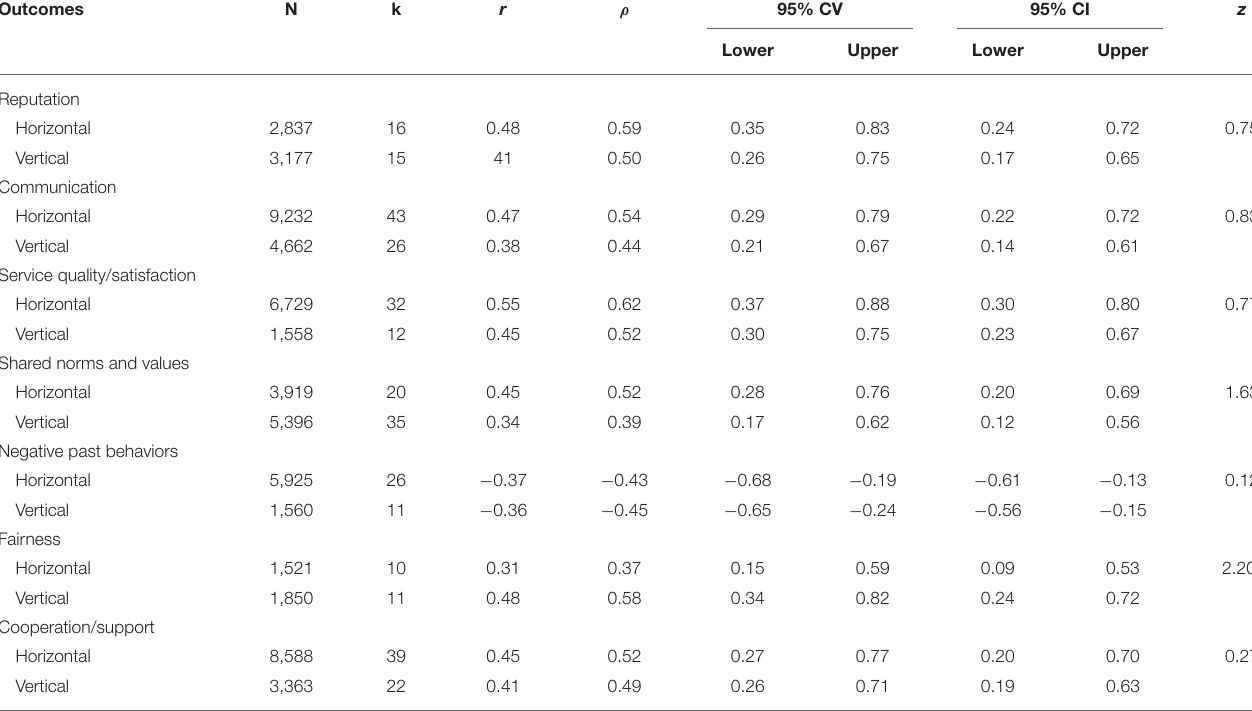
TABLE 6 | Moderator analysis of type of relationship and meta-analytic antecedents of trust.